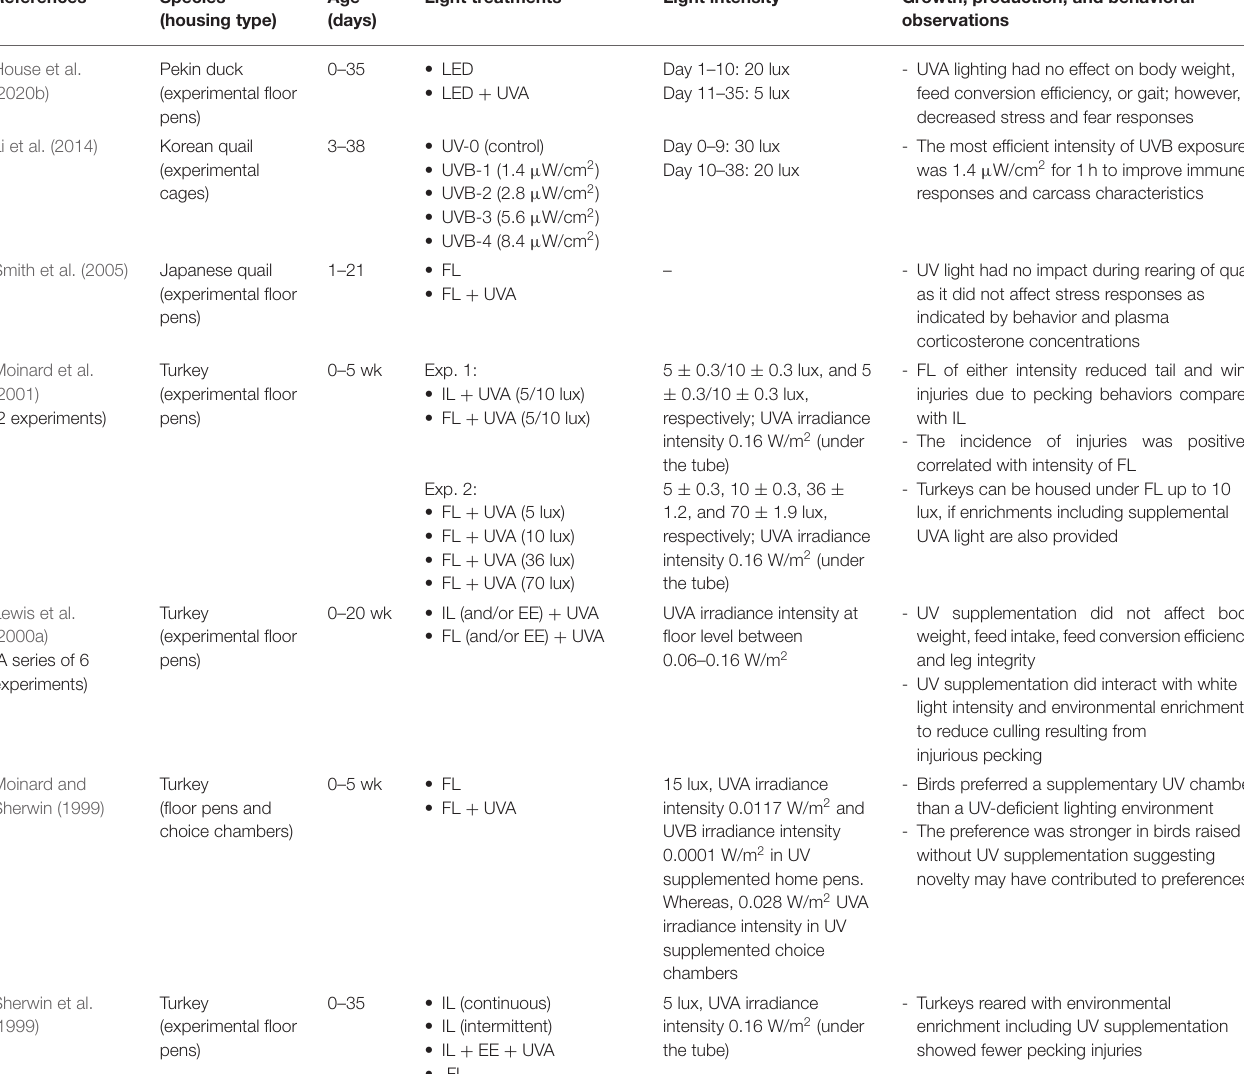
TABLE 5 | Effects of UV light on behavior, growth, and production of other poultry